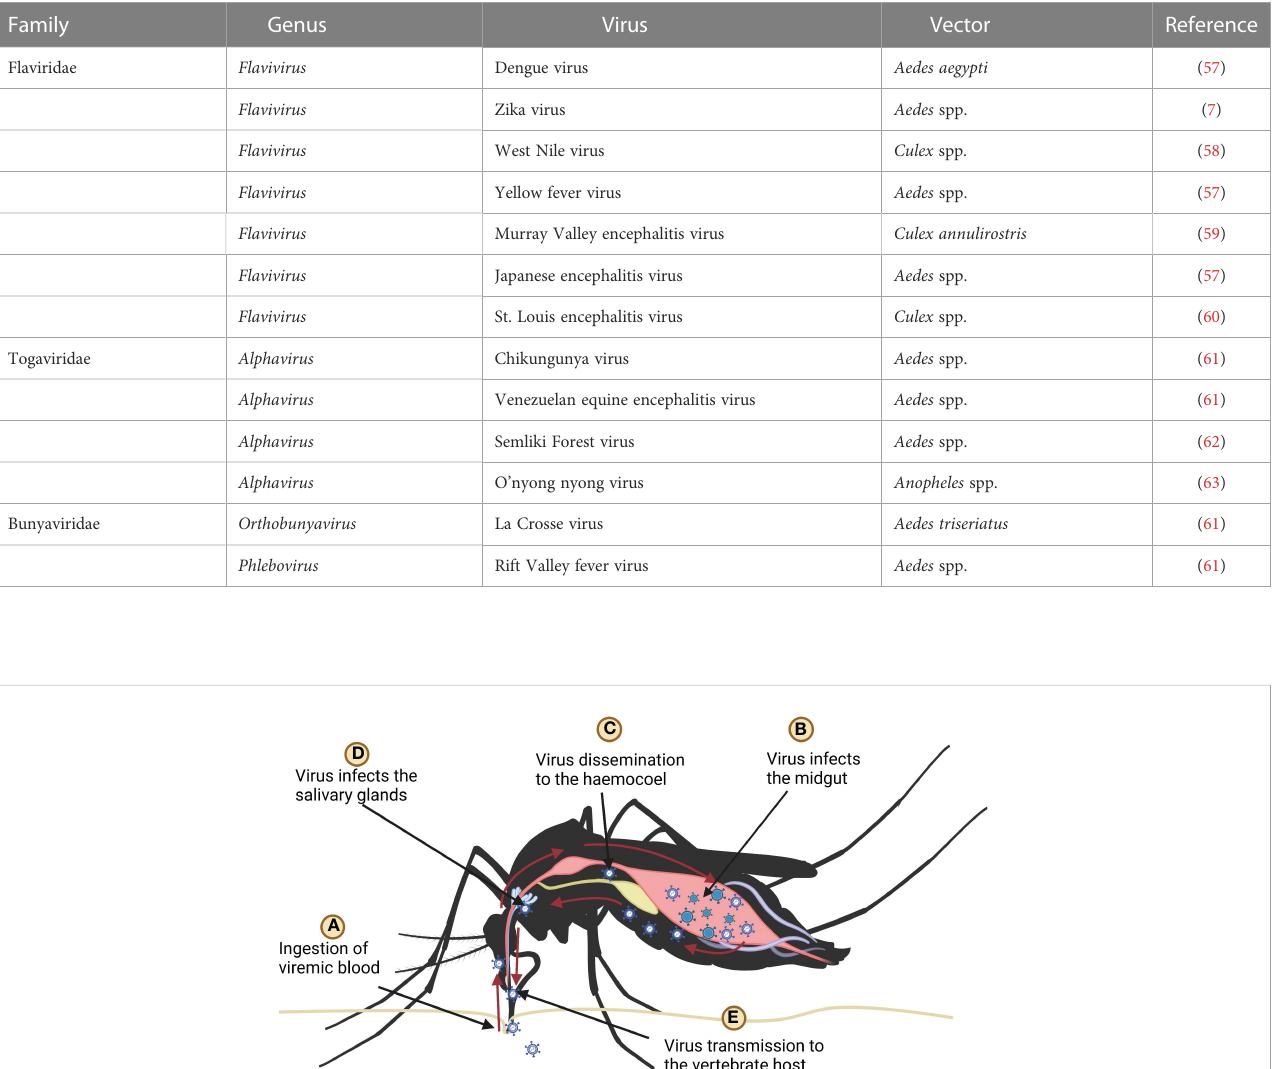
TABLE 1 Mosquito-borne viruses.